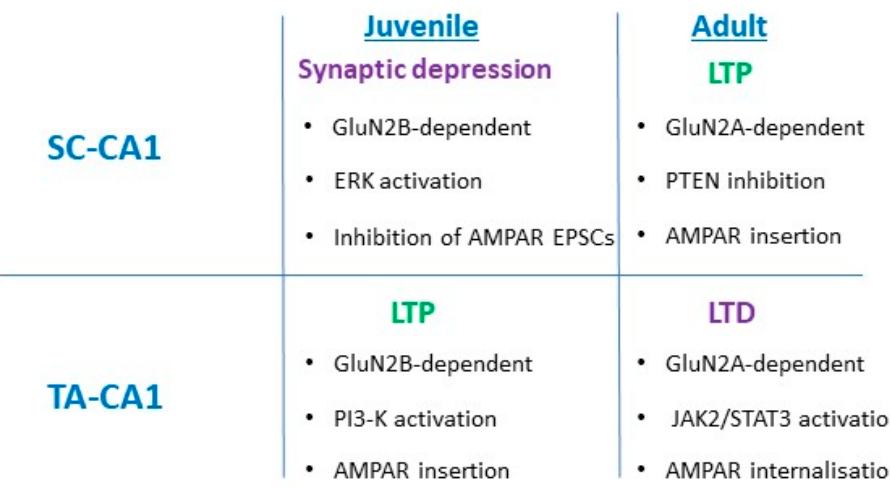
Figure 2. Summary of the differential effects of leptin at Schaffer collateral (SC)-CA1 and temporoammonic (TA)-CA1 synapses. Treatment of juvenile hippocampus with leptin results in a transient synaptic depression at SC-CA1 synapses that involves GluN2B activation and stimulation of ERK. Conversely, leptin induces LTP at juvenile TA-CA1 synapses, which requires GluN2A activation and PI 3-kinase-driven synaptic insertion of GluA2-lacking AMPA receptors. At adult SC-CA1 synapses, leptin induces a novel form of LTP that is also NMDA receptor-dependent and involves synaptic insertion of GluA2-lacking AMPA receptors following inhibition of PTEN. In contrast, leptin induces long-term depression (LTD) at adult TA-CA1 synapses, and this process requires GluN2A activation and JAK2/STAT3 signalling, which results in AMPA receptor removal from synapses.